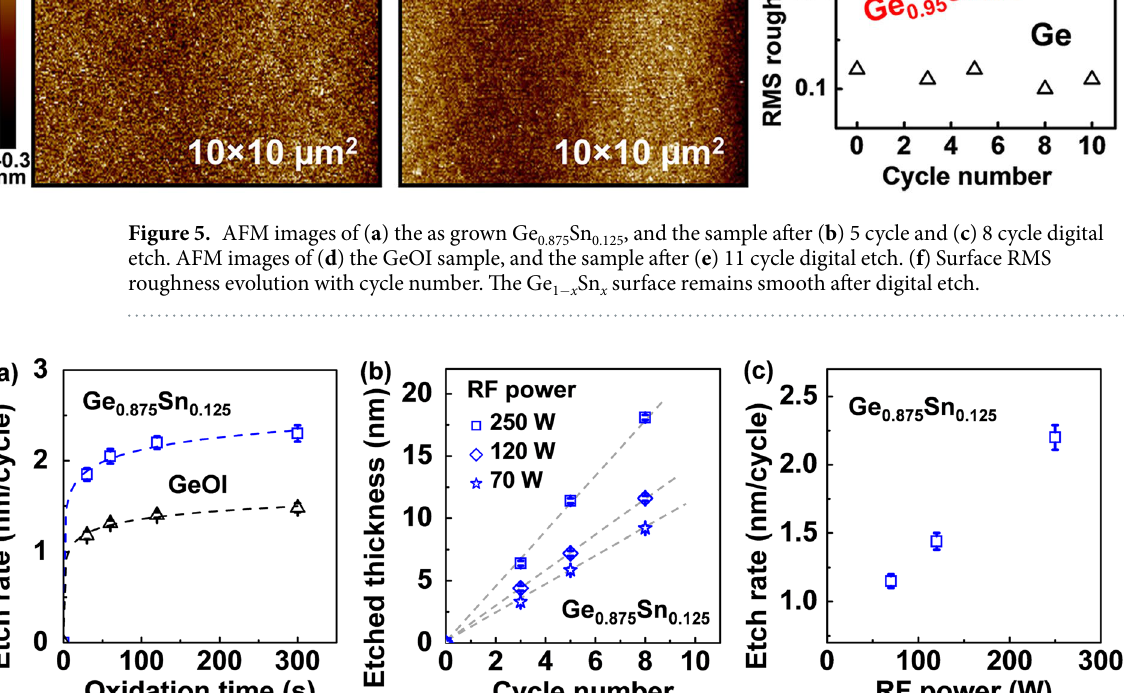
different oxidation rates for Ge and Sn. Figure 6a shows the measured Ge and Ge 0.875 Sn 0.125 digital etch rates as a function of plasma oxygen exposure time. The RF power is fixed at 250 W. It is noted that for both the Ge and Ge 0.875 Sn 0.125 samples, the etch rate increases rapidly for the first 120 s of oxidation time, and then saturates fast to a etch rate of ~1.4 and ~2.2 nm/ cycle, respectively. Deal and Grove proposed that the thermal oxidation rate could be determined by a combi- nation of two processes 47 . One is the actual chemical reaction of oxygen O at the interface, and the other is the diffusion of oxygen through the previously formed oxide film. The combination of these processes resulted in